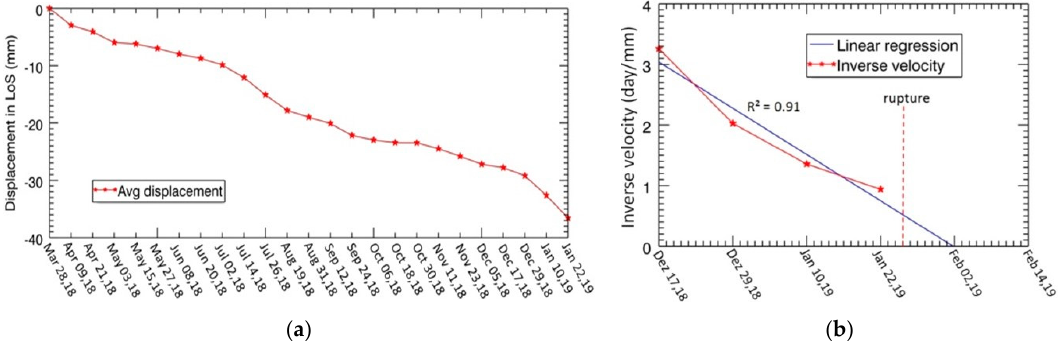
Figure 12. PSI average displacement ( a ) and inverse of the velocity graph with linear regression ( b ).